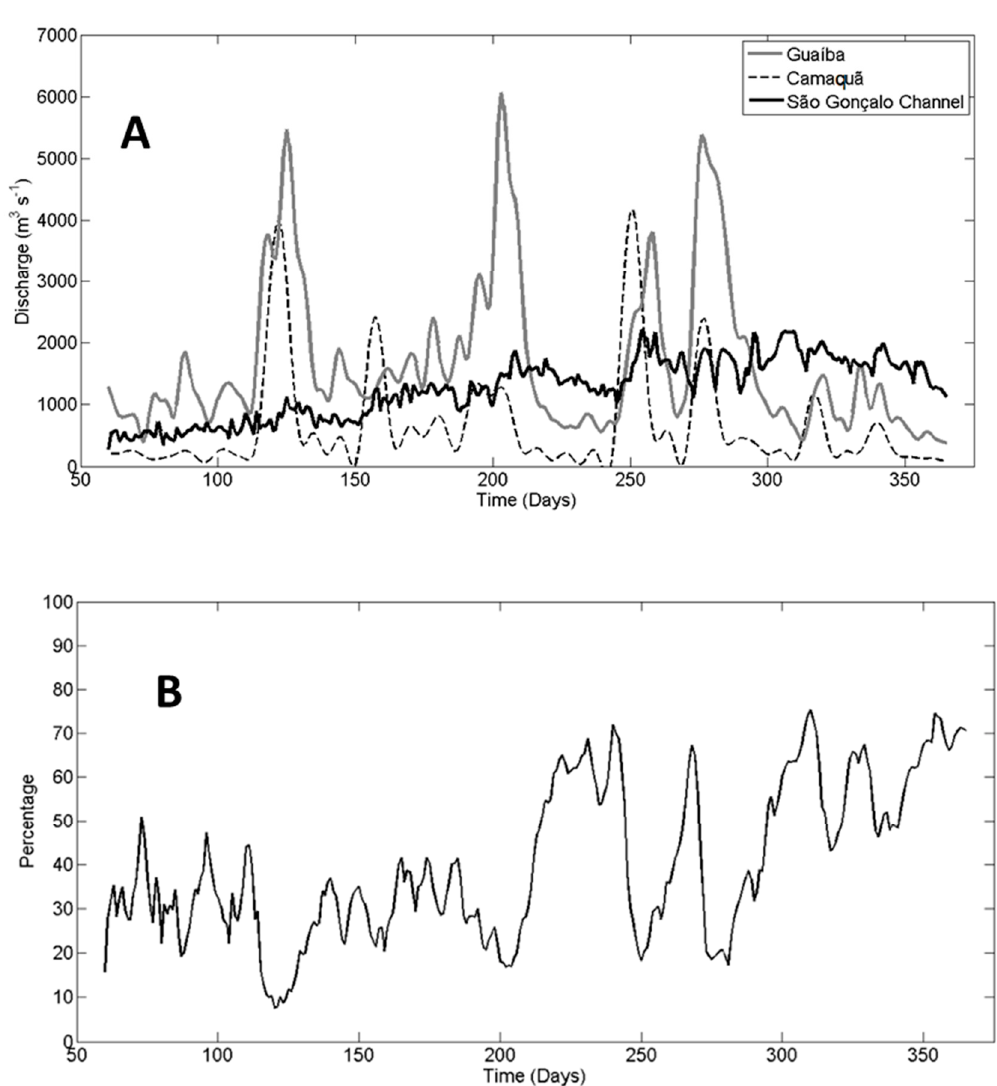
Figure 13. ( A ) Discharge time series from Guaíba (dashed line) and Camaquã (gray line) rivers, and simulated São Gonçalo channel (black line) discharge to the Patos lagoon. ( B ) Mirim lagoon freshwater contribution via São Gonçalo channel to the Patos lagoon during the simulated period (2002).